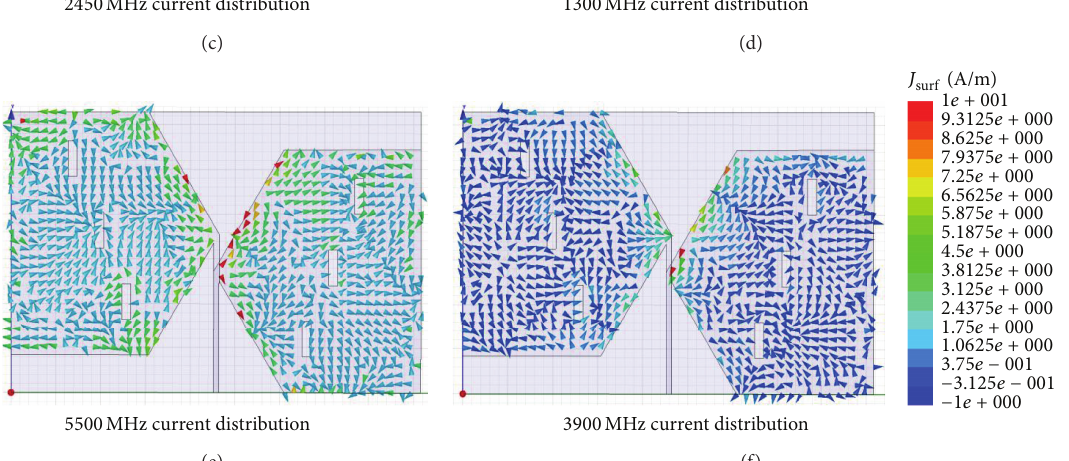
Figure 3: Simulated current density versus frequency on the modified bow-tie dipole